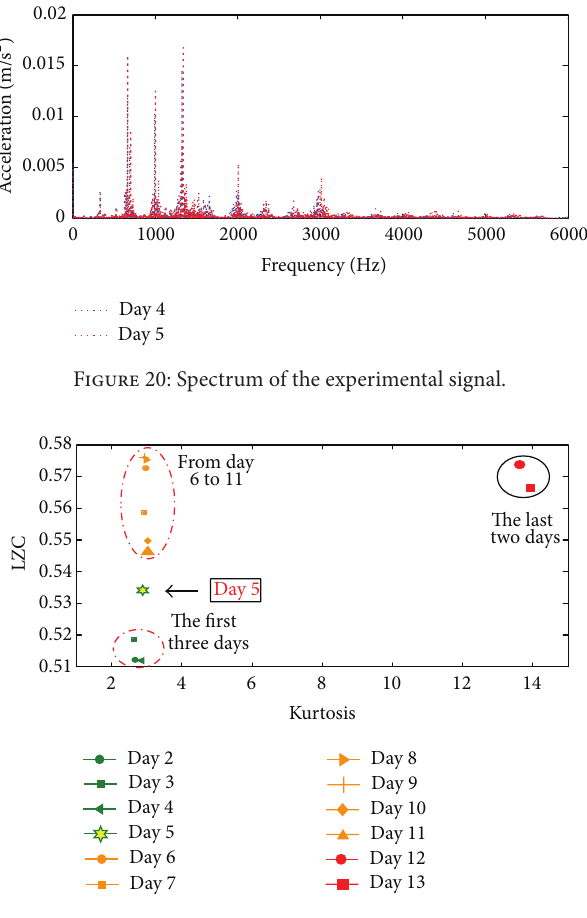
Figure 21: Kurtosis versus LZC value during the test for all